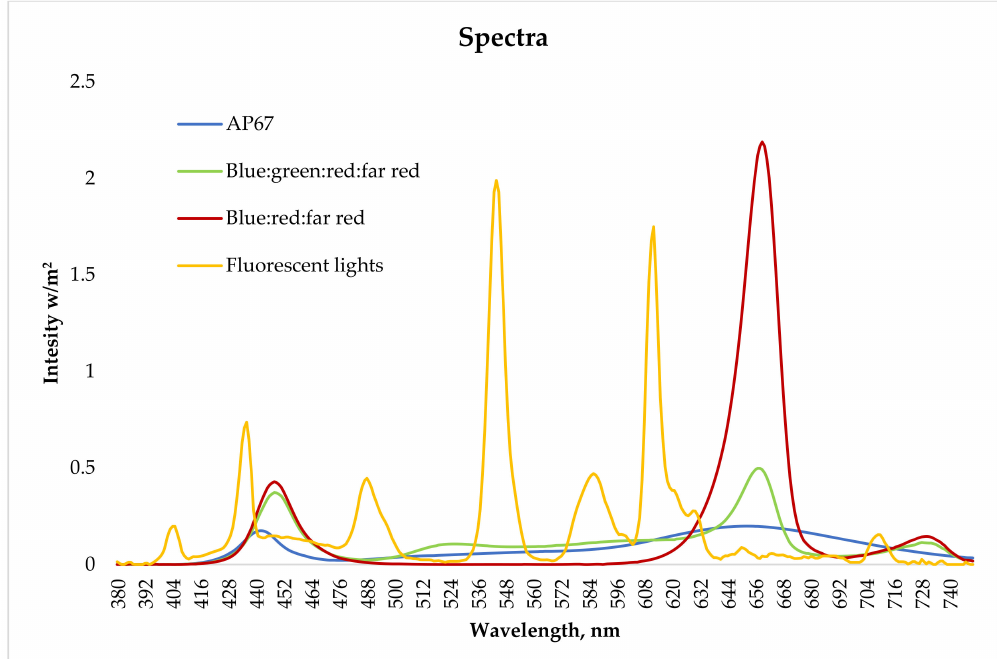
Figure 2. The spectra and intensities of the fluorescent and led lights used in the germination experiments (Experiment III). In the maturation experiment (Experiment II) AP67, blue:green:red:far red, and blue:red:far red spectra were used, but the intensities were